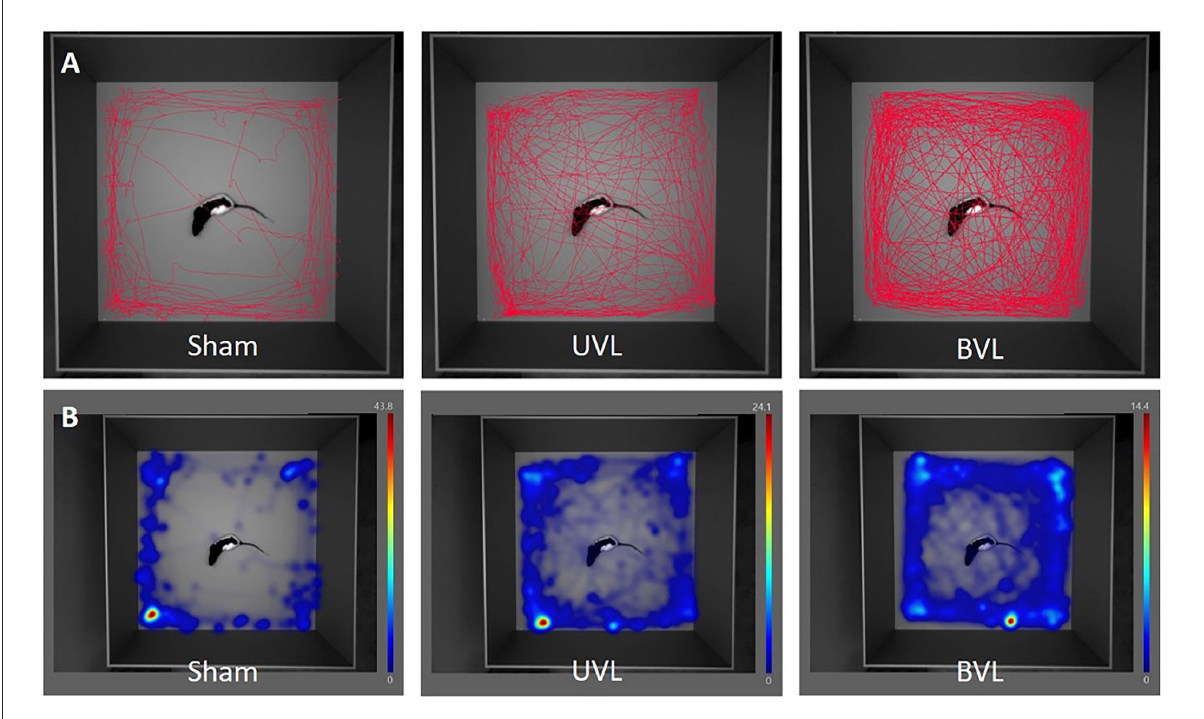
FIGURE8 Movement tracing (A) and heatmaps (B) of center-point over 10min analysis in the open-field at W3 after sham surgery (left), at W3 after unilateral TT injection (middle), and at W4 after the sequential bilateral TT-injection